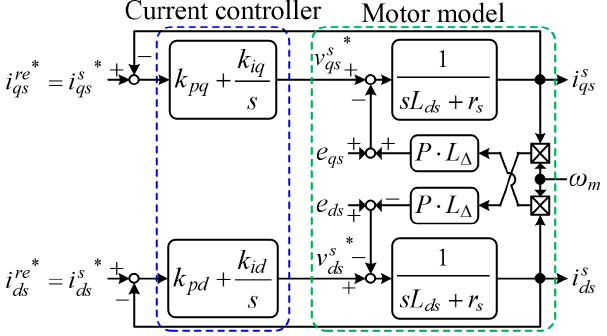
Figure 4. Equivalent stationary frame current control loop.